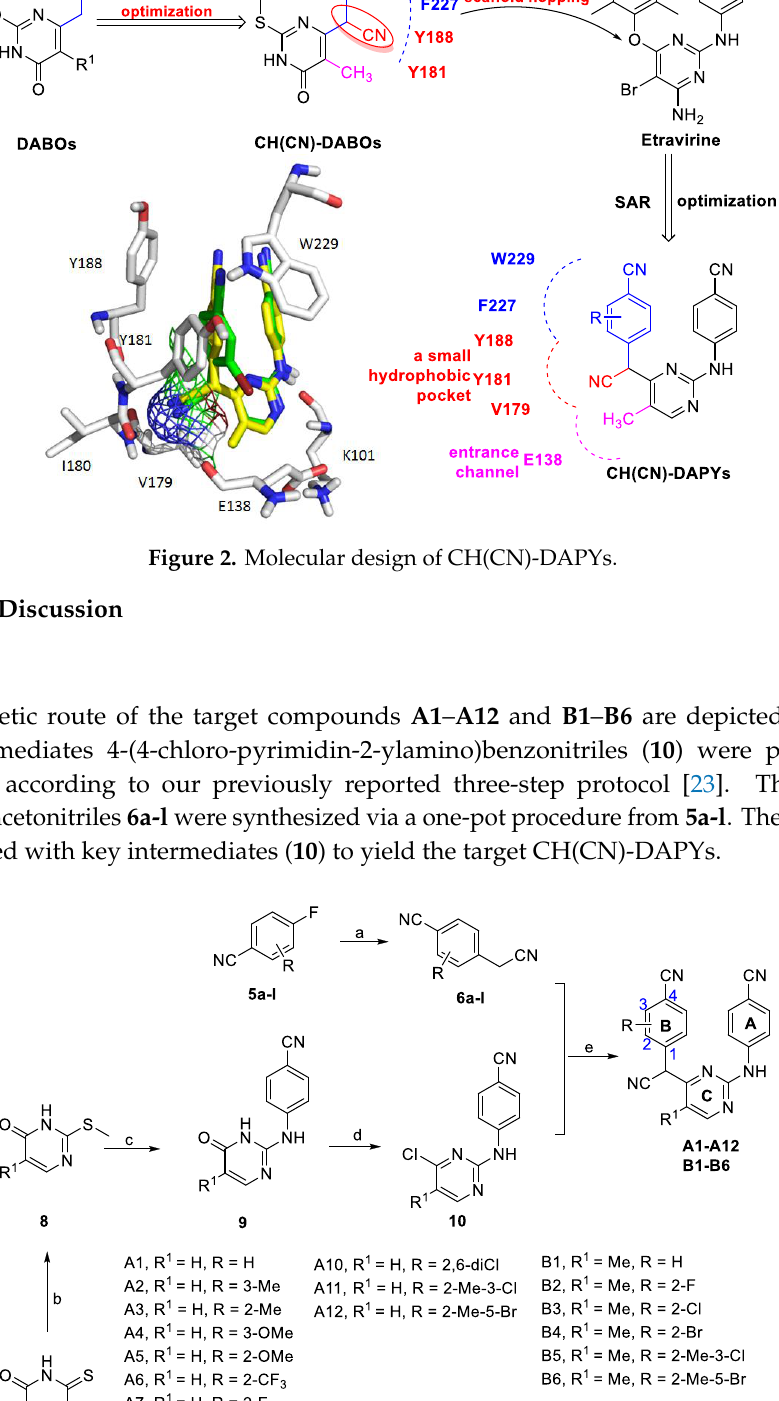
Figure 2. Molecular design of